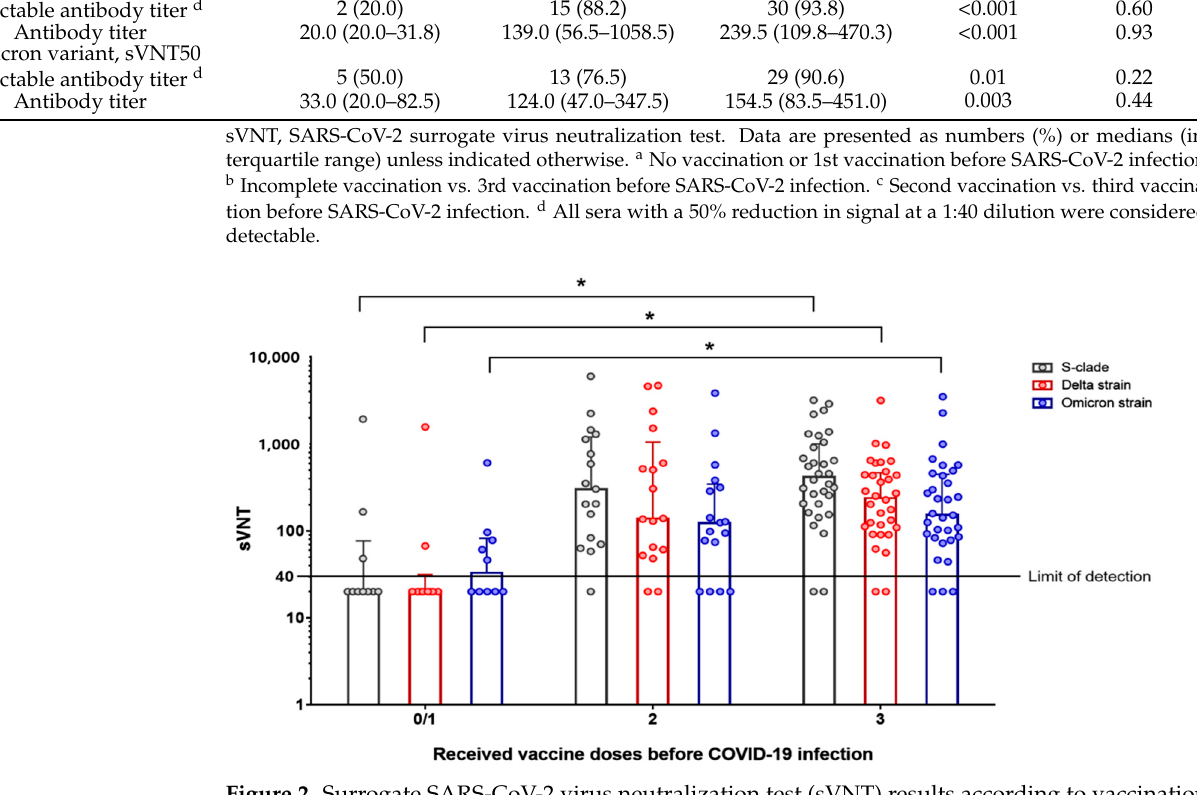
Table 2. Comparison of serologic results in each cohort of patients aged ≥ 60 years according to their vaccination history before SARS-CoV-2 infection.